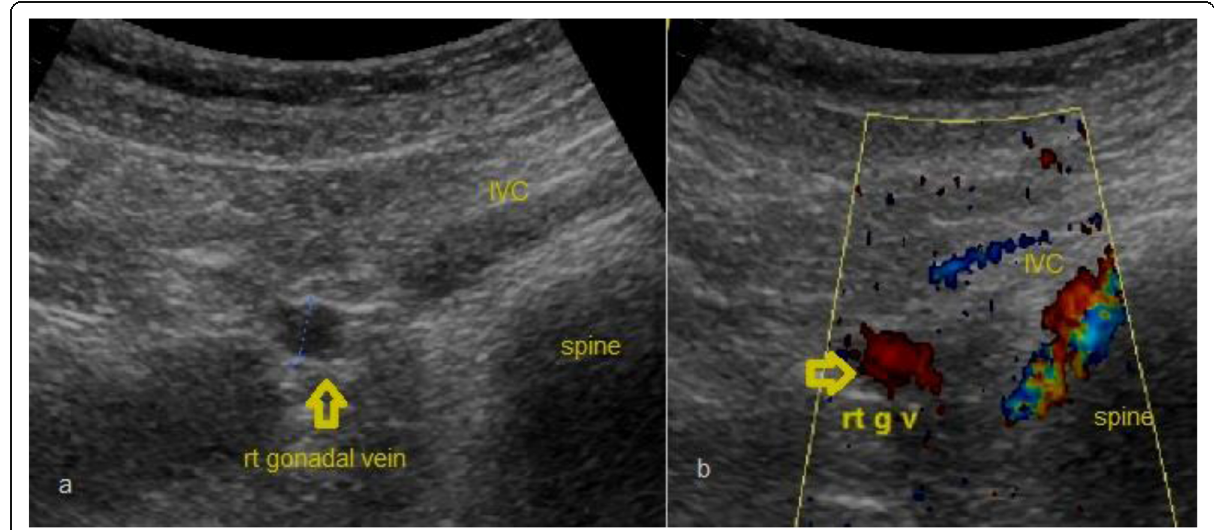
Fig. 6 a Trans-abdominal ultrasound and b color Doppler images showing right gonadal vein dilatation (open yellow arrow) on the right side of the IVC and the spine b) demonstrating right gonadal vein reflux (coded in red, open yellow arrow) by raising the abdominal